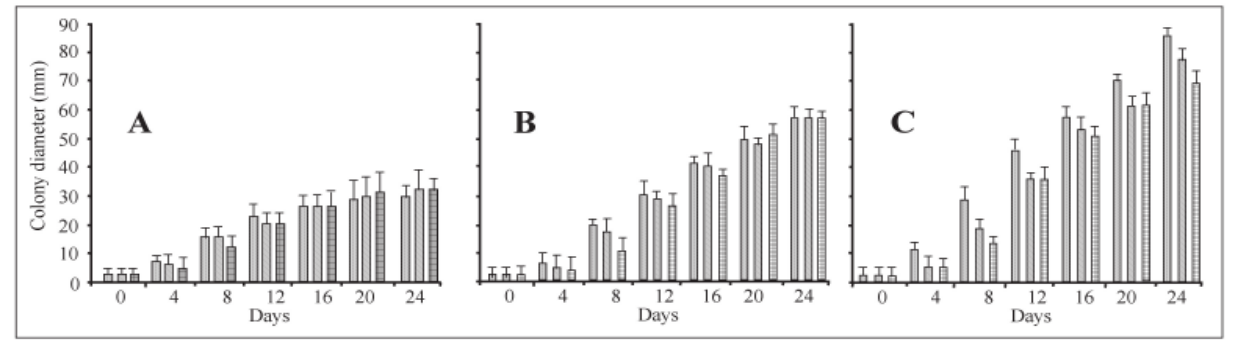
Fig. 4. Growth rates of Phaeomoniella chlamydospora (A), Phaeoacremonium aleophilum (B) and Fomitiporia punctata (C) grown with vitroplants of grapevine cv. Italia ( ), Sangiovese ( ) and Matilde ( ). Standard error bars are